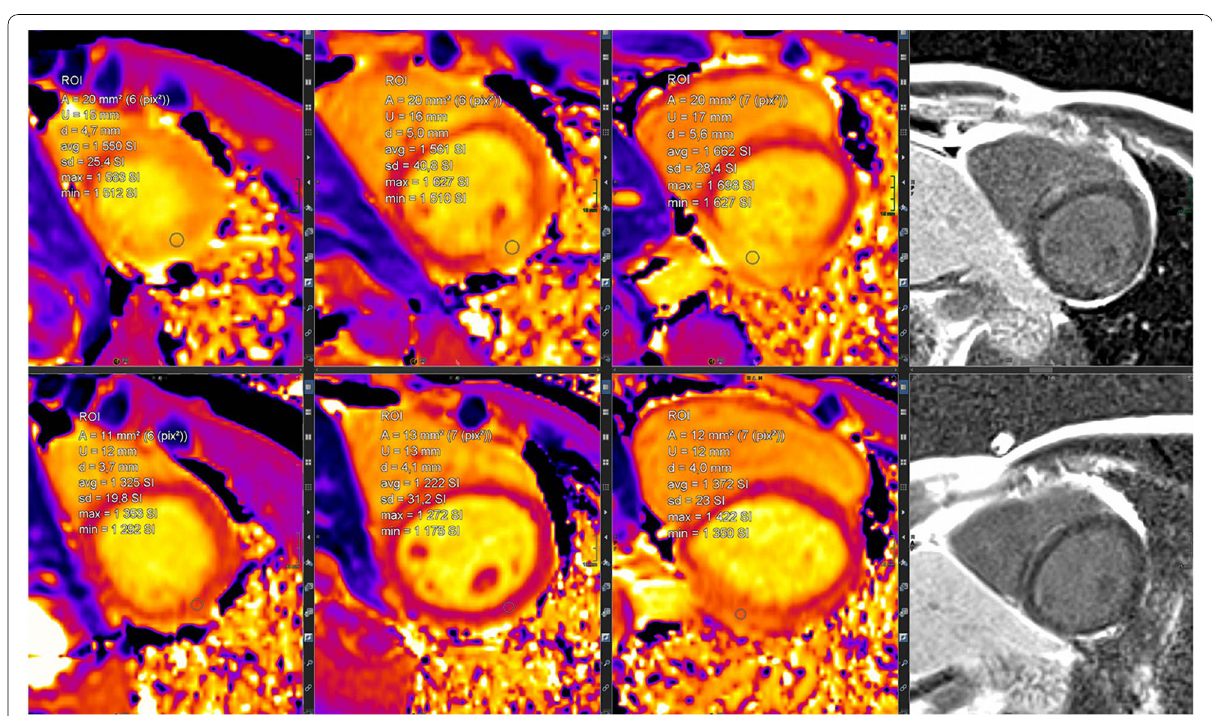
Fig. 18 (T1 mapping during follow-up): normalization of initially increased signal intensities in anteroseptal LV myocardium (upper row—baseline with 1550/1561/1662 ms; lower row—follow-up with 1325/1222/1372 ms). The likewise changes of T2 and LGE signal plus T2 as well as T1